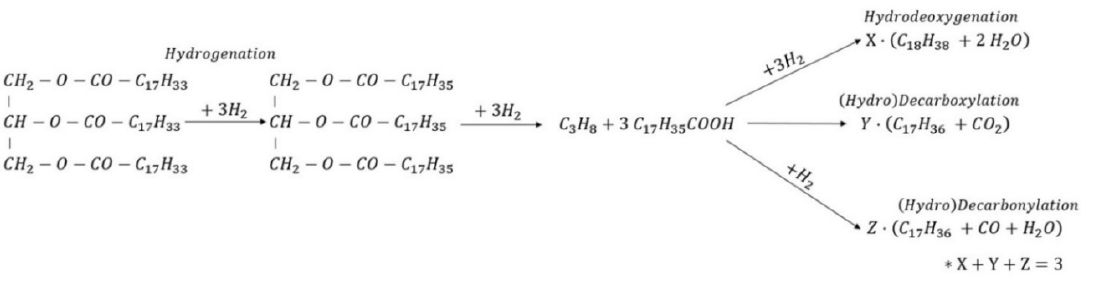
Figure 3. Co-processing of vegetable oils in hydrotreating units of current refineries.